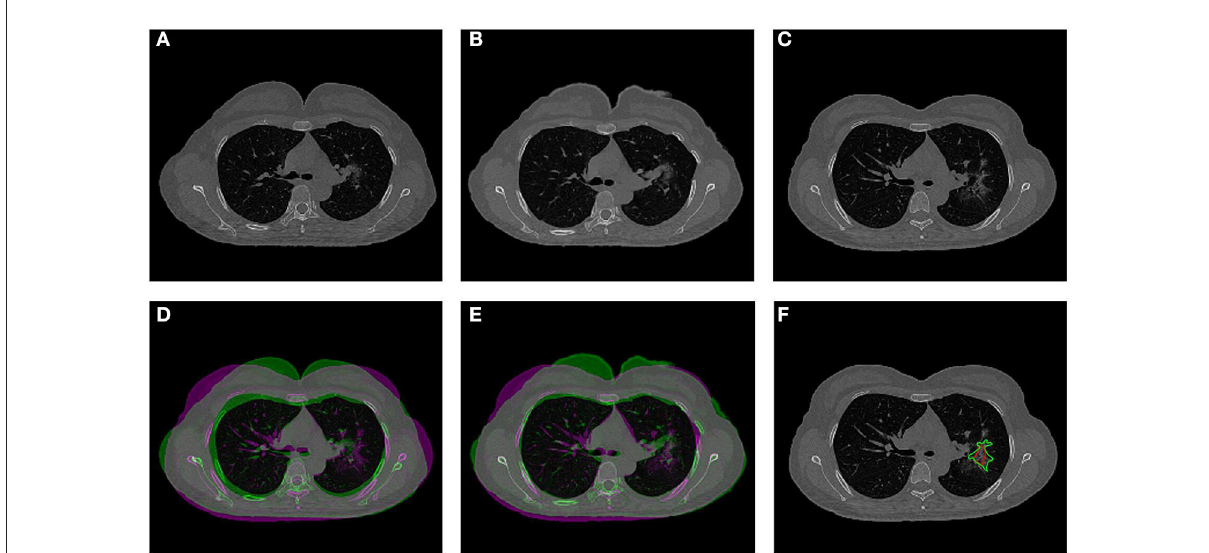
FIGURE3 An example from a 52-year-old female patient. (A) Baseline image. (B) The transformed baseline image to match the F/U after completing the two-step Affine and Demons algorithms. (C) The first F/U image. (D) Comparison between the transformed baseline image after the first-step Affine registration and the first F/U image by the overlay. When the signal intensity on F/U is higher than on B/L, the pixel is labeled using purple color; when the intensity on F/U is lower than on B/L, it is labeled using green color. (E) Comparison between the final transformed baseline image and the first F/U image. It can be seen that the difference is smaller and the lung areas are better matched. (F) Overlay of the transformed B/L lesion (red contour) and the labeled first F/U lesion (green contour) on the F/U image, showing matching locations.